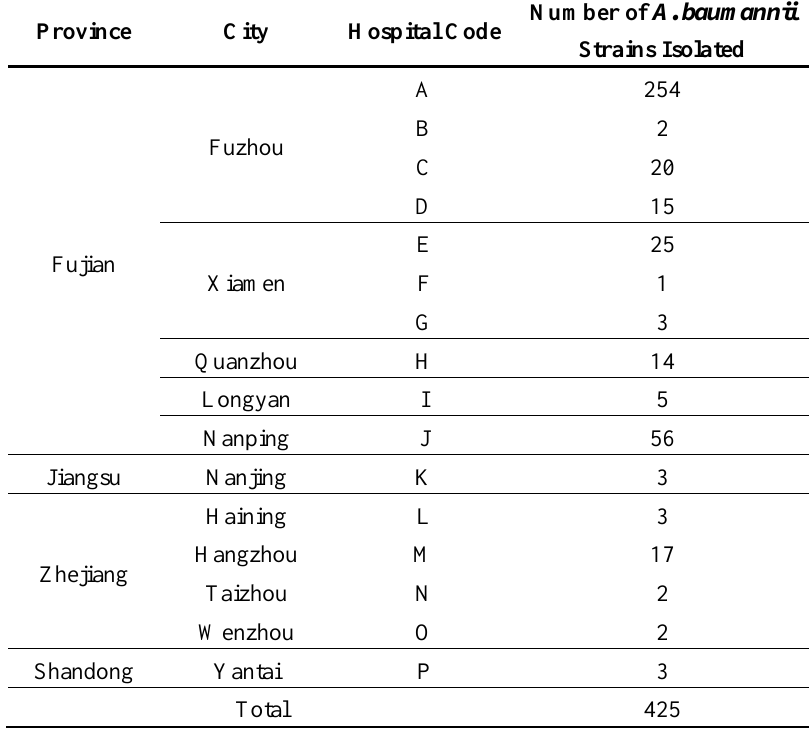
Table 1. Number of A. baumannii strains isolated from 16 hospitals in eastern